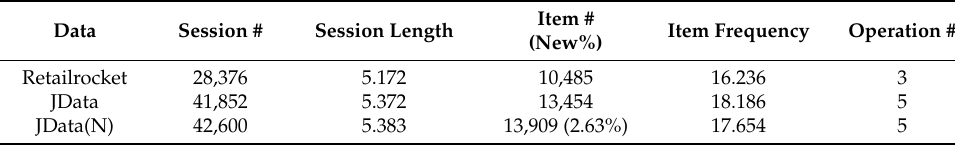
Table 1. Data set statistics